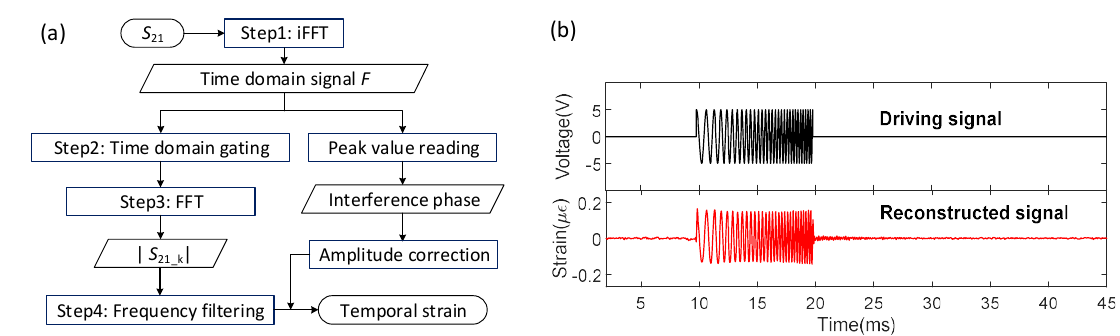
Figure 4. ( a ) Signal flow chart for temporal signal reconstruction. ( b ) Driving and reconstructed chirp signals.